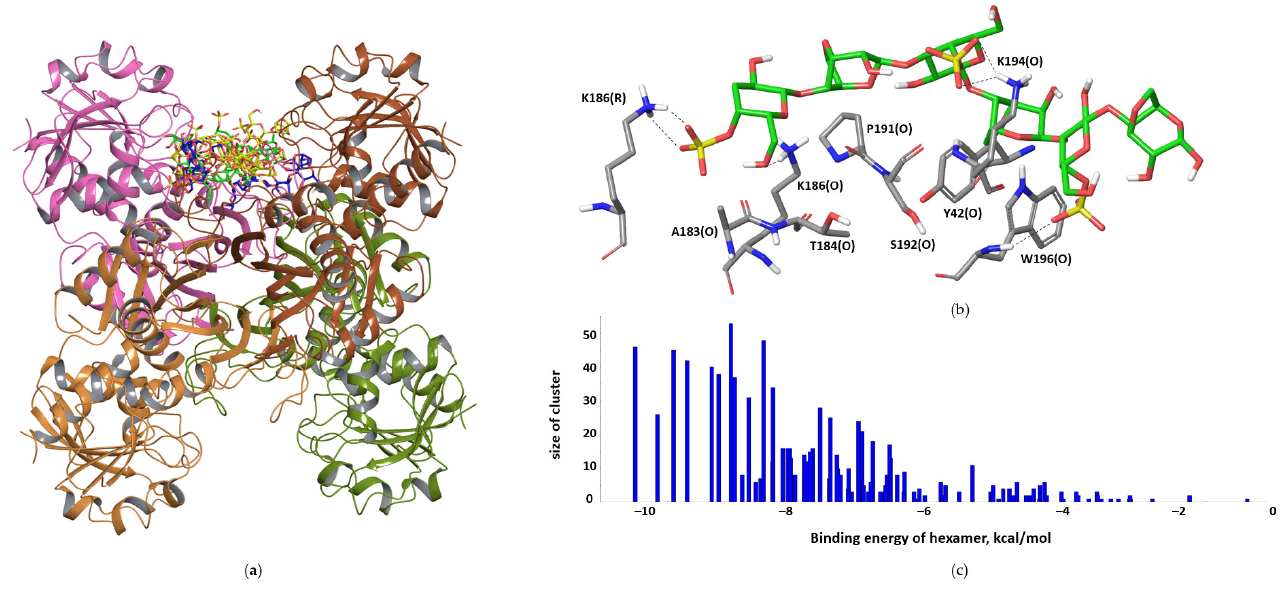
Figure 5. The superimposition of the most favorable binding poses located in the OR groove of tetramer (carbon atoms in yellow), OR-dimer (carbon atoms in green) and OP-dimer (carbon atoms in blue) ( a ). A representative of the binding mode to GAPDH tetramer ( b ). The plot of cluster size versus its binding energy ( c ).